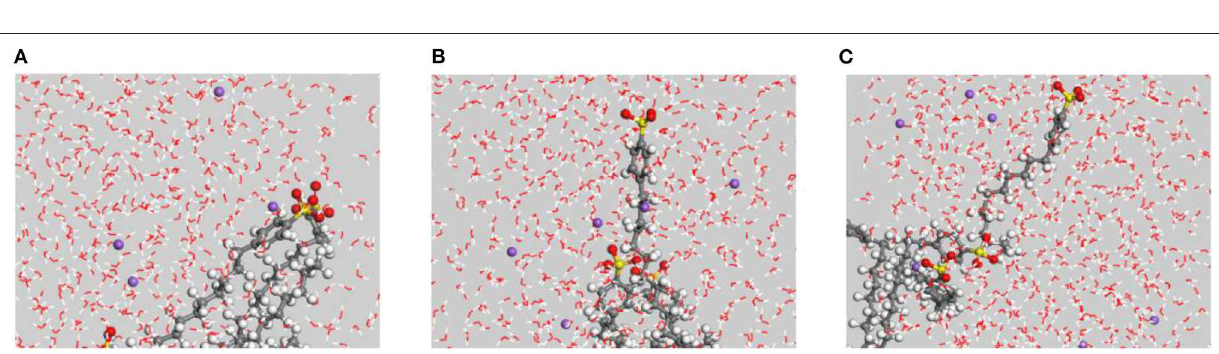
FIGURE 4 | Na + aggregation in the SDBS system. The purple sphere is Na + . (A) 0 ps, (B) 400 ps, and (C) 800